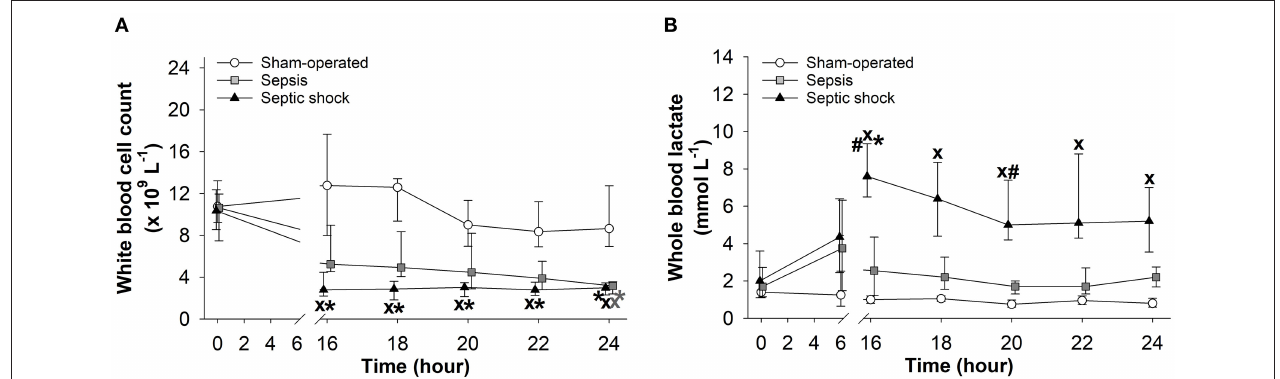
FIGURE 4 | Changes in white blood cell count (A) and whole blood lactate levels (B) in the sham-operated group (open circles) and the sepsis (gray square) and septic shock subgroups (black triangle). The plots demonstrate the median values and the 25th (lower whisker) and 75th (upper whisker) percentiles. X P < 0.05 vs. sham-operated group; # P < 0.05 vs. sepsis group; * P < 0.05 vs. t = 0h.